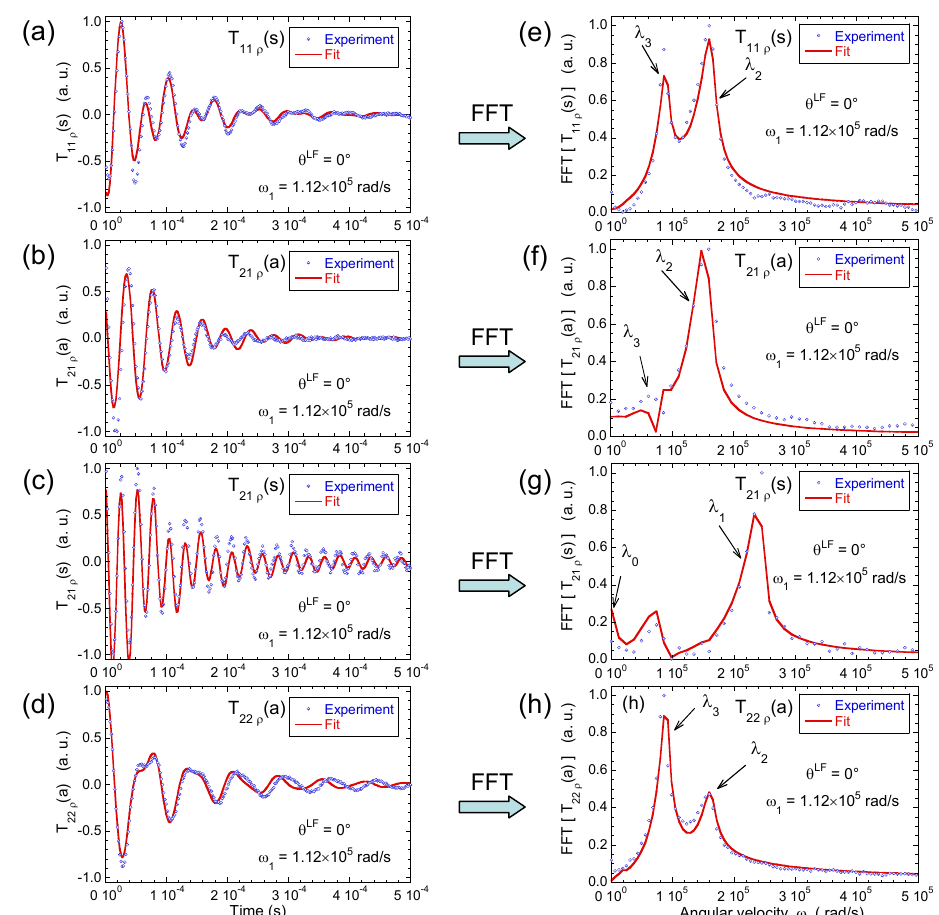
Figure 9. Time evolution of ( a ) T 11 ( s ) ; ( b ) T 21 ( a ) ; ( c ) T 21 ( s ) and ( d ) T 22 ( a ) coherences measured under spin-locking conditions, noted T 11 ρ ( s ) , T 21 ρ ( a ) , T 21 ρ ( s ) and T 22 ρ ( a ) , respectively; and their Fourier transforms for ( e ) T 11 ( s ) ; ( f ) T 21 ( a ) ; ( g ) T 21 ( s ) and ( h ) T 22 ( a ) coherences ( 2 H NMR). Reprinted with permission from [23]. Copyright (2014) American Chemical Society.